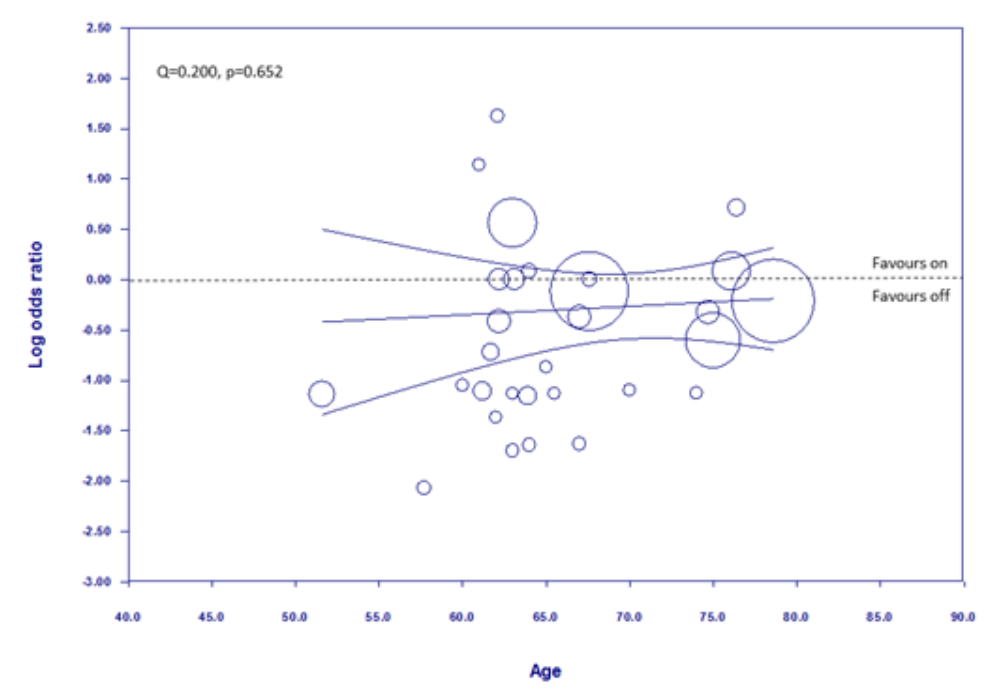
Fig. 5 – Weighted random-effects meta-regression analysis regressing the log odds ratio (OR) of stroke against age in the off-pump group. Negative values of the log OR mean more benefits for stroke associated with off-pump. The size of the circle corresponds to the inverse variance of the log OR, and thus is related to the statistical weight of the individual trial. The curved lines represent the 95% confidence intervals.